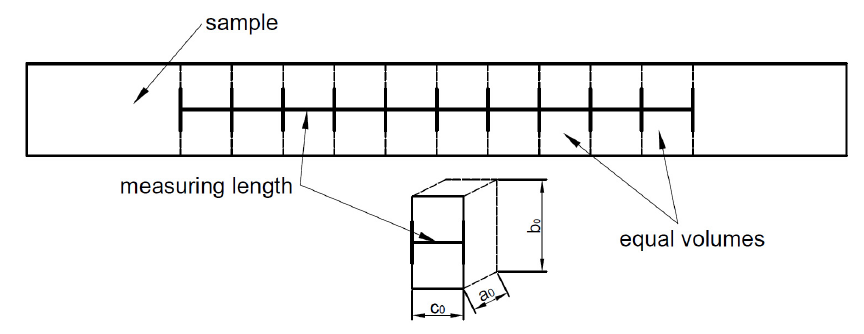
Figure 20. Volume division of the sample before the elongation.